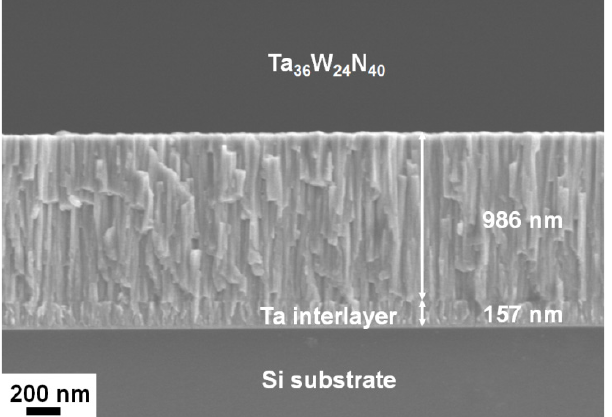
Figure 1. XSEM image of the Ta 36 W 24 N 40 film prepared on a Si substrate.